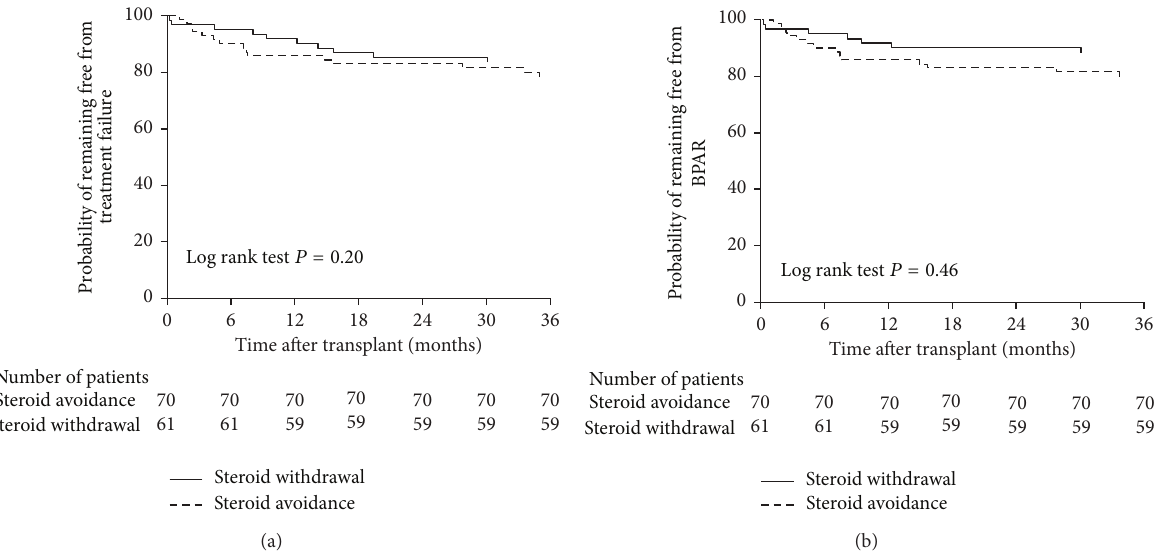
Figure 2: Kaplan-Meier estimates of the probability of remaining free from (a) treatment failure (BPAR (central review), graft loss, death, or loss to follow-up) or (b) BPAR.